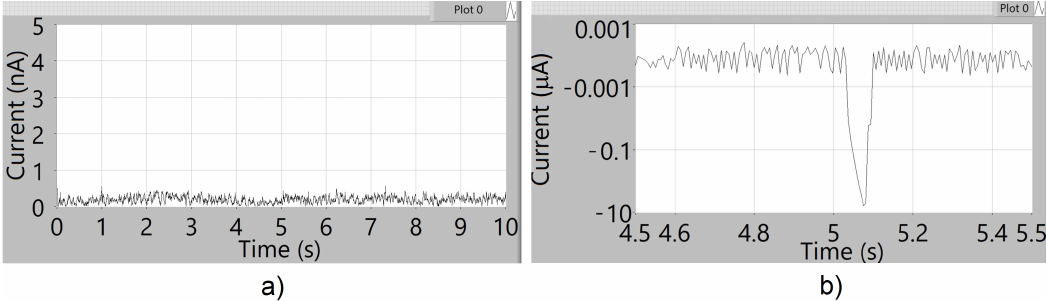
Figure 11. Current in GEM BOTTOM 1. ( a ) Current in the stable state. ( b ) Current with a discharge, the plot shows the current in logarithmic scale.